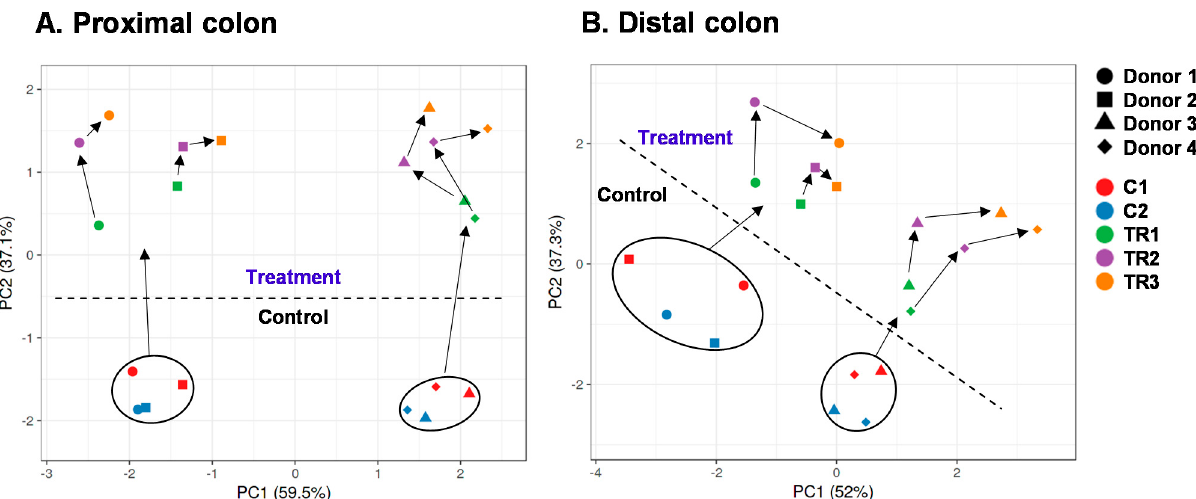
Figure 2. Principal component analysis (PCA) based on microbial metabolic activity in the proximal ( A ) and distal ( B ) colon during the control and treatment with cRG-I, as tested for four human adult donors 1, 2, 3, and 4 in the quad-M-SHIME. The PCA is based on the average values for each donor and for each experimental week (5 weeks: 2 control weeks (C1/C2) and 3 treatment weeks (TR1/TR2/TR3)). The following data were included: acidification, acetate, propionate, butyrate, ammonium, and bCFA. Arrows indicate the evolution of samples along the duration of the experiment. bCFA = branched-chain fatty acids, cRG-I = carrot-derived Rhamnogalacturonan I.